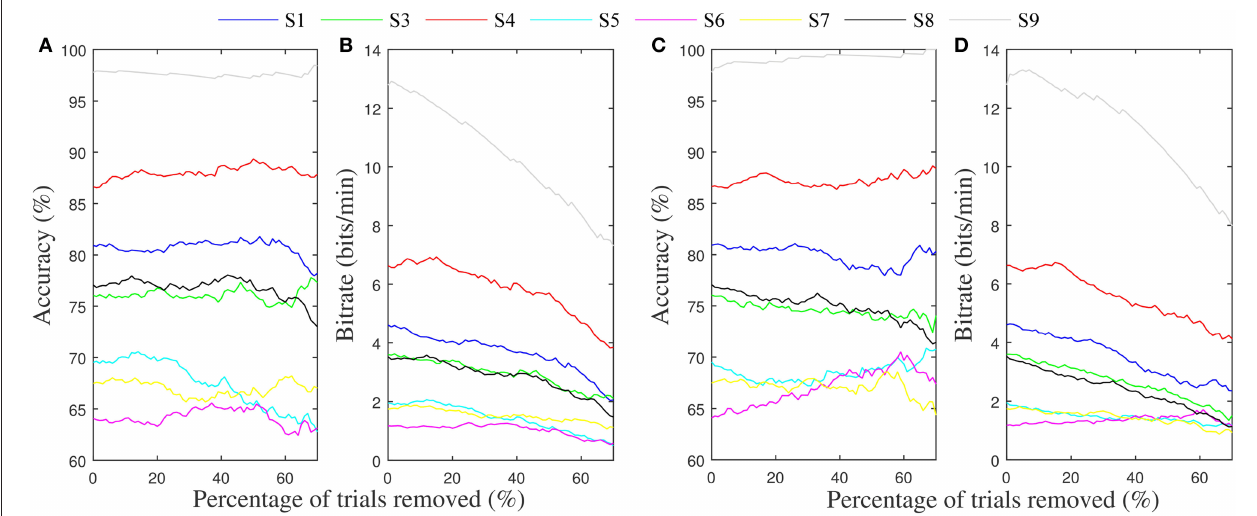
FIGURE 7 | Average accuracy and bit rates from the four-folds of the gating simulation. (A) Average accuracy achieved for each subject after gating up to 70% of trials randomly. (B) Resulting bit rate. (C) Average accuracy achieved for each subject after gating of trials up to 70% based on a linear combination of mu rhythm amplitude and MFV features. (D) Resulting bit